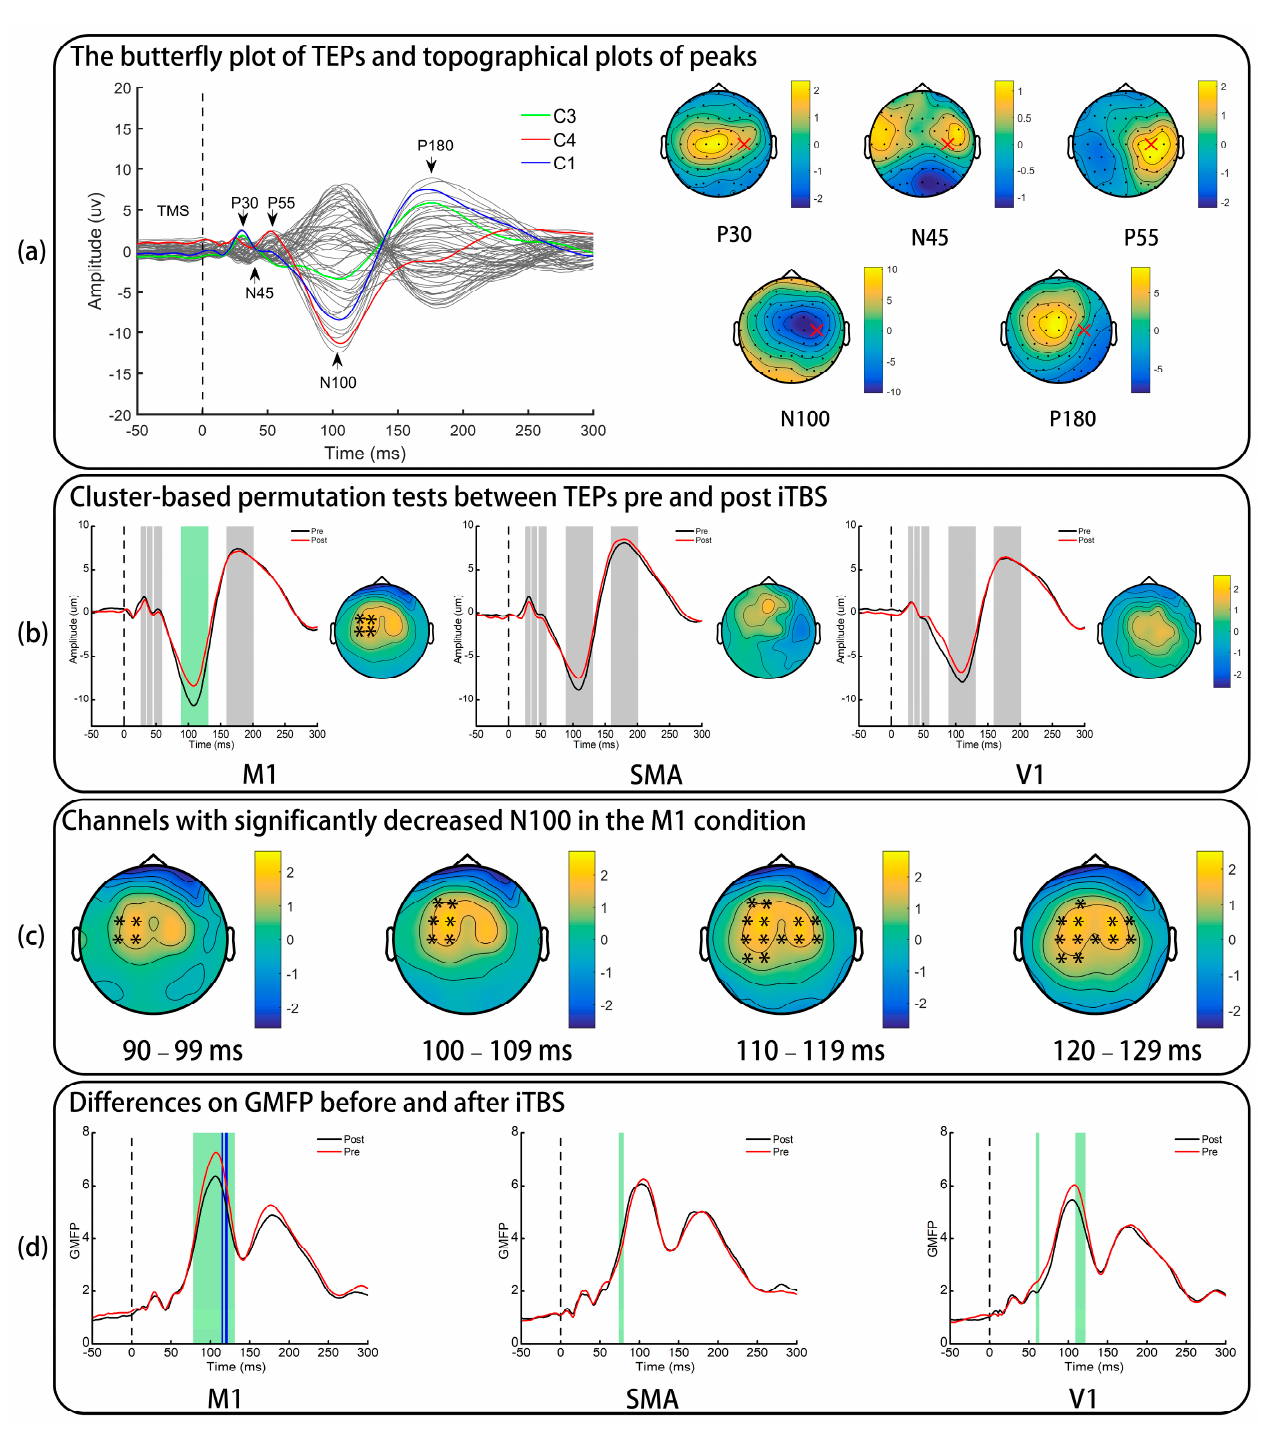
Figure 2. The effect of iTBS in TMS-evoked potentials. ( a ) Only pre-iTBS data of the M1 condition are presented. “x” indicates the stimulation site. ( b ) TEP difference of a representative electrode (FC1). The grey shadows indicate the predefined time windows of five peaks and the green shadow indicates the significant difference in the N100 of M1 TEPs. Topographical plots are the difference of N100 amplitudes (post − pre) and “*” represents electrodes with a significant difference. ( c ) “*” represents electrodes with a significant difference induced by iTBS to the M1 in four small time windows of N100. ( d ) The global mean field power pre- and post-iTBS. Green shadows indicate a significant difference identified by paired t -tests and the blue shadows indicate comparisons survived after FDR corrections were applied. TEPs: TMS-evoked potentials; iTBS: intermittent theta burst stimulation; M1: primary motor cortex; SMA: supplementary motor area; V1: primary visual cortex; GMFP: global mean field